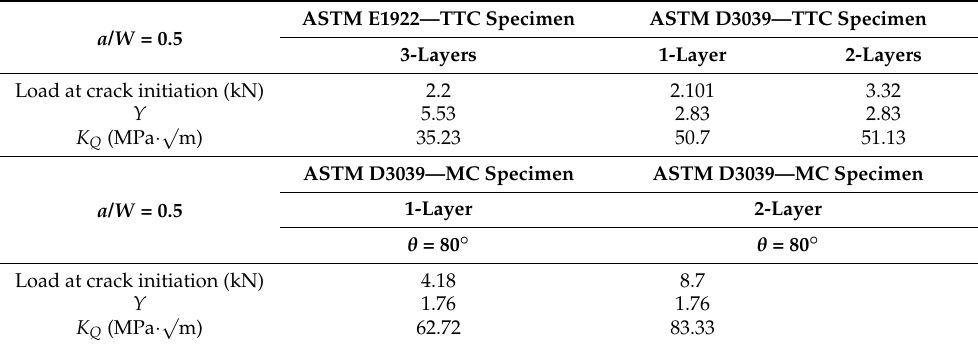
Table 10. The apparent fracture toughness ( K Q ) and the geometry correction factor ( Y ) for TTC specimens with ( a/W =